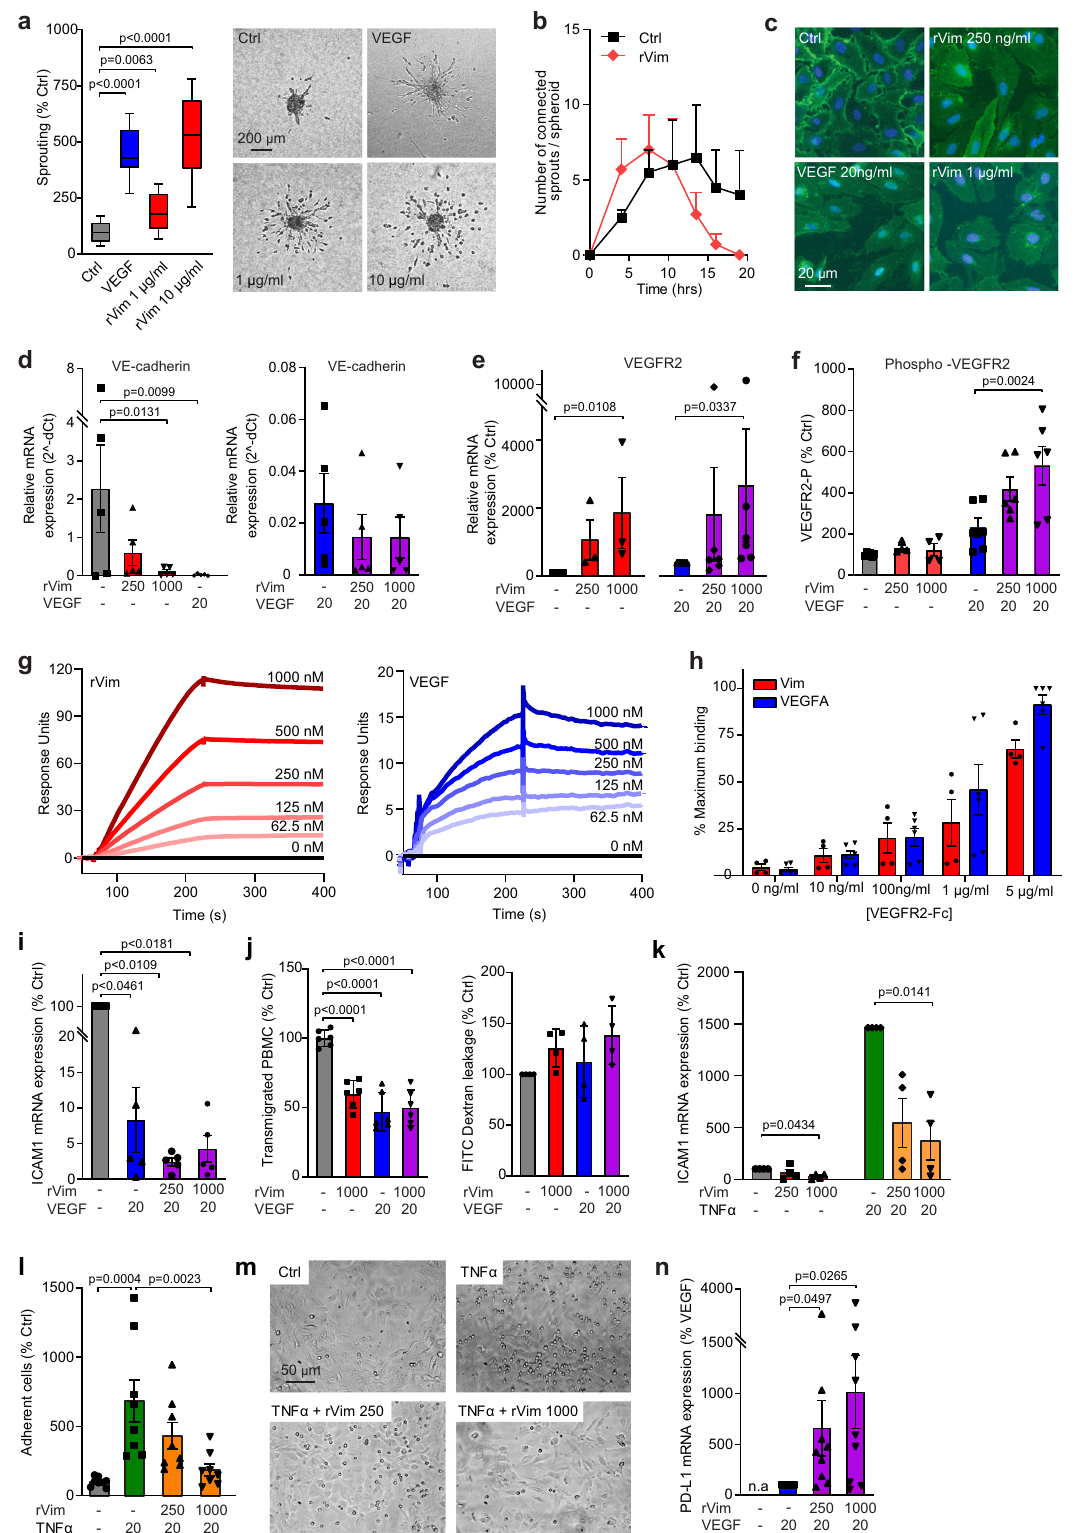
showed localization of the antibodies to the tumor vessel wall (Fig. 3f). Treatment of xenografted human CRC on the CAM with anti-vimentin antibodies inhibited both tumor growth and vascular density in the tumors (Fig. 3g, h), and resulted in increased necrosis (Supplementary Fig. 4a). Moreover, these antibodies could be detected in the perivasculature in